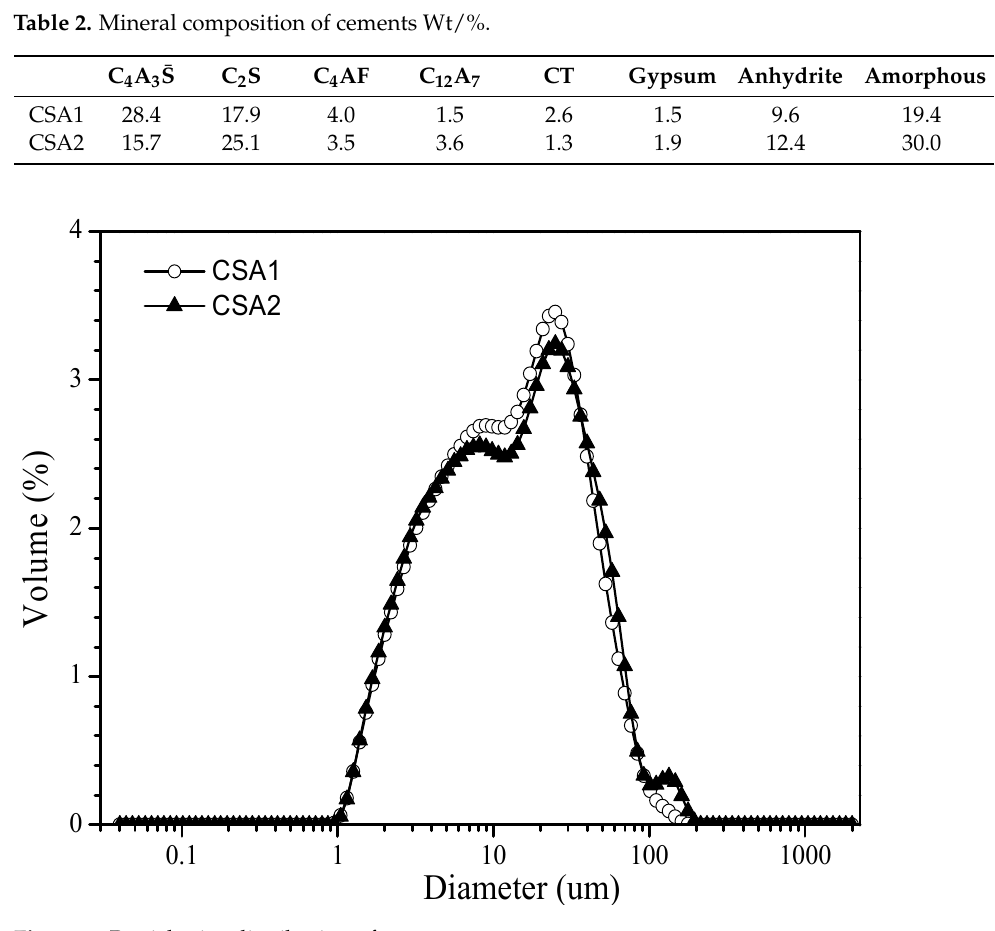
Figure 1. Particle size distribution of cements.